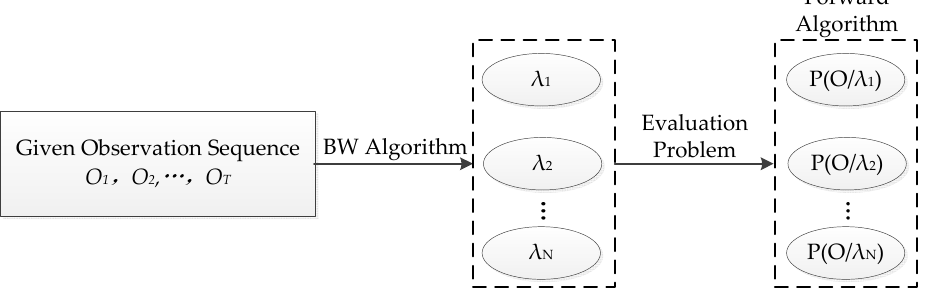
Figure 1. Graphica l illustration of the evaluation problem.